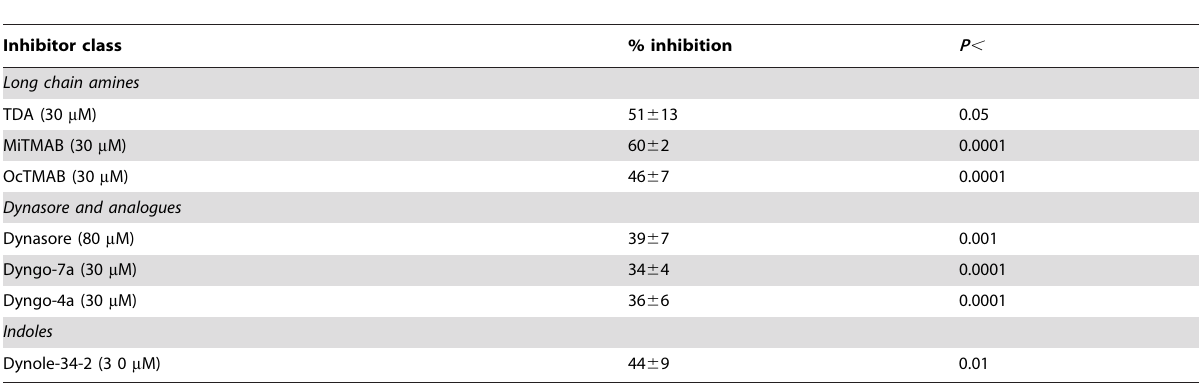
Table 1. Inhibition of apoE secretion by dynamin